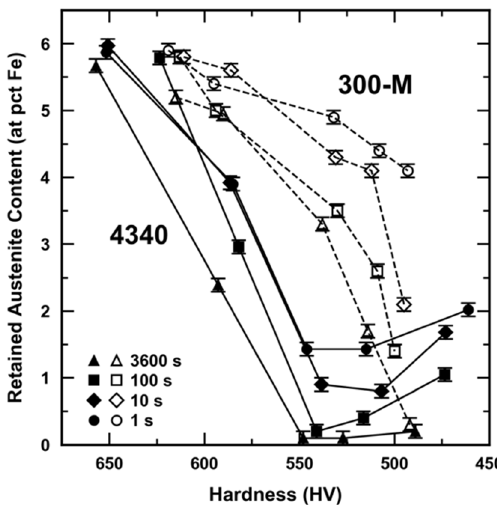
Figure 3. Retained austenite content (at pct Fe) as a function of tempered hardness for all time conditions of 4340 (closed) and 300-M (open). Hardness is represented on a decreasing scale. Represented error is associated with the uncertainty of the measurement technique, Mössbauer spectroscopy [3]. Figure is reproduced from [6] with permission.